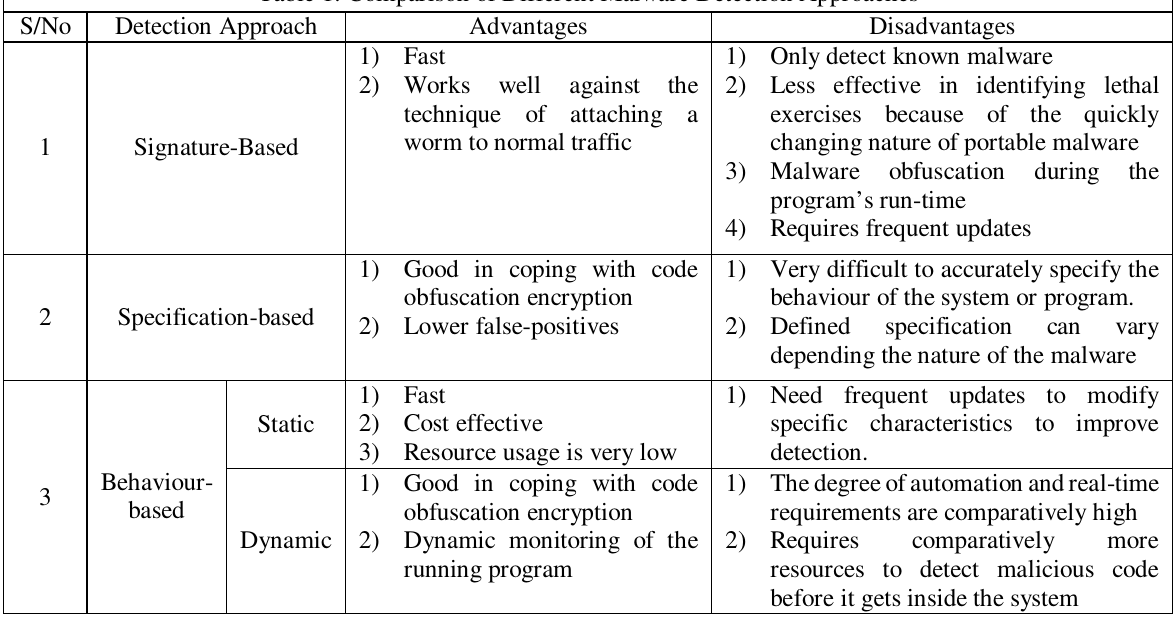
Table 1: Comparison of Different Malware Detection Approaches S/No Detection